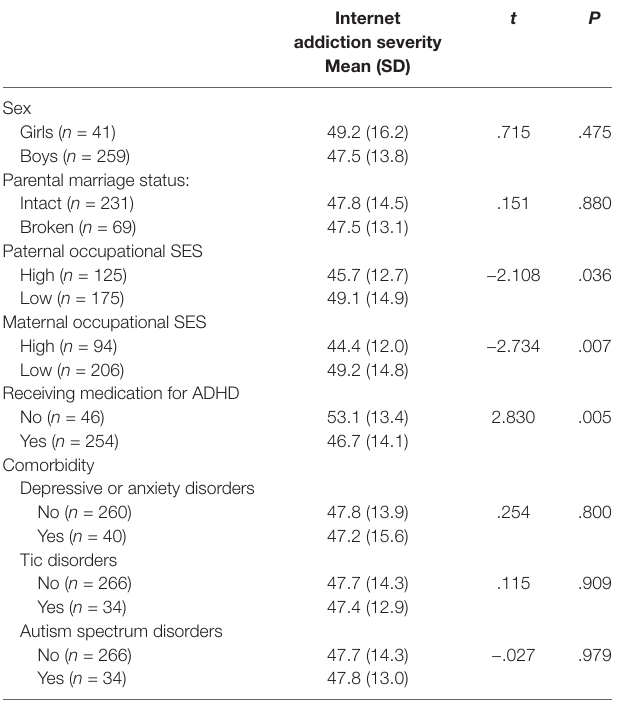
TABLE 3 | Comparison of internet addiction severity of participants according to sociodemographic characteristics, ADHD characteristics, and comorbidities. Internet addiction